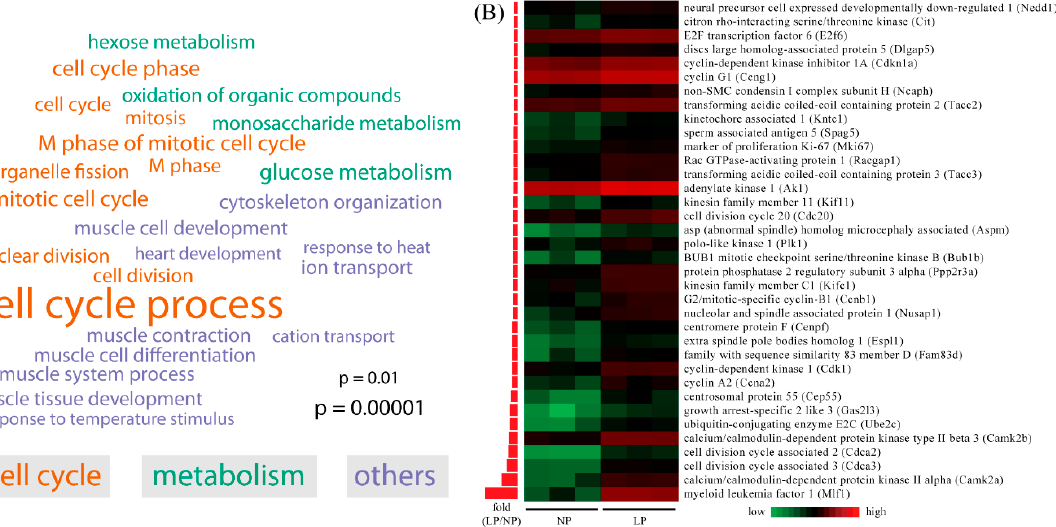
Figure 2. Gene ontology (GO) analysis of differentially expressed genes. ( A ) Word cloud of enriched GO terms in the biological process category for differentially expressed genes. The enrichment test was performed using the DAVID tool and the significance cutoff for adjusted p -value was set at 0.01. The font sizes in the word cloud are proportional to –log10 of adjusted p -value for each enriched GO terms; ( B ) Heatmap of the 36 differentially expressed genes that fall into the biological process of cell cycle. FPKM values were log-transformed and centered relative to the median. The fold change values are presented as bars on the right of the heatmap in ascending order. The range of fold changes is 2.00–74.66.